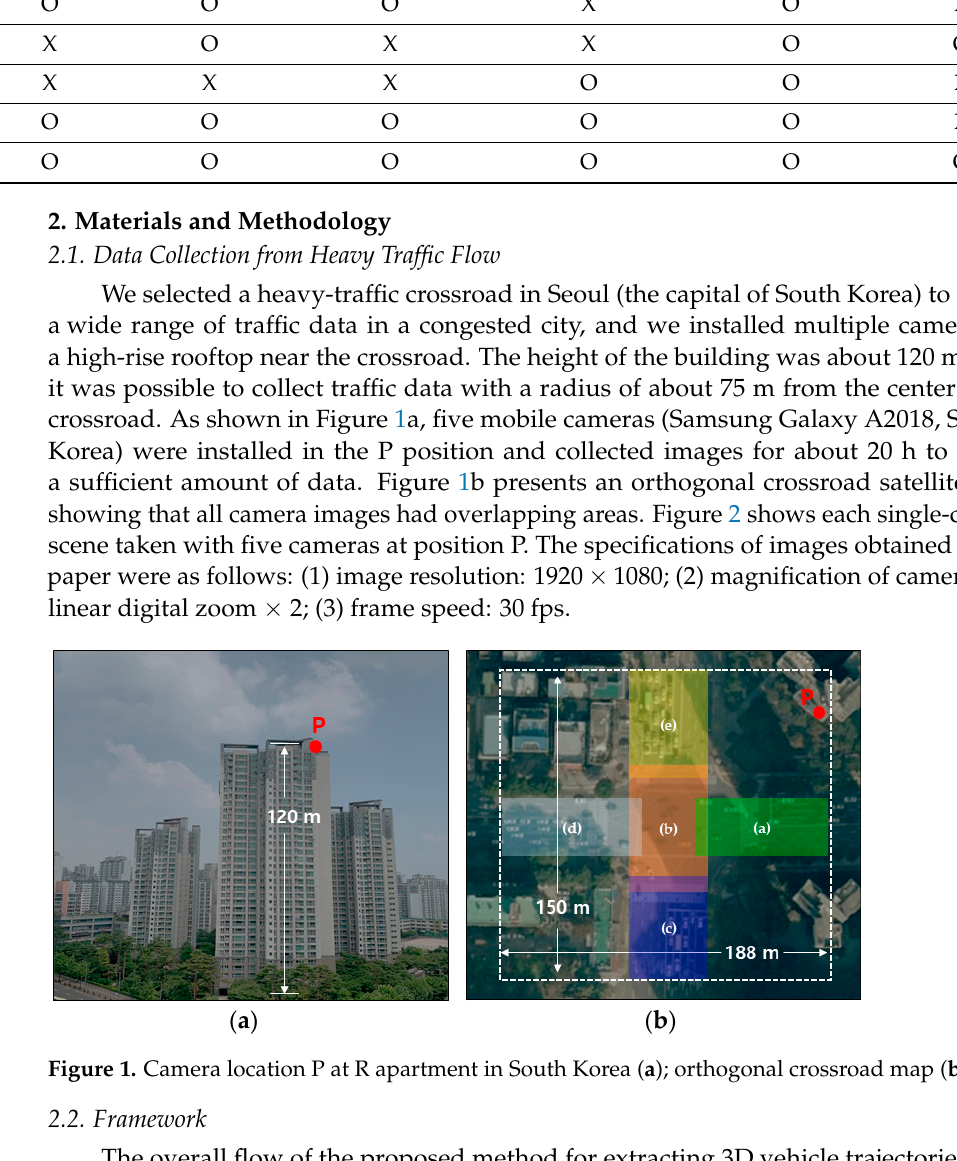
Table 1. Comparison of different 3D vehicle trajectory extraction algorithms.